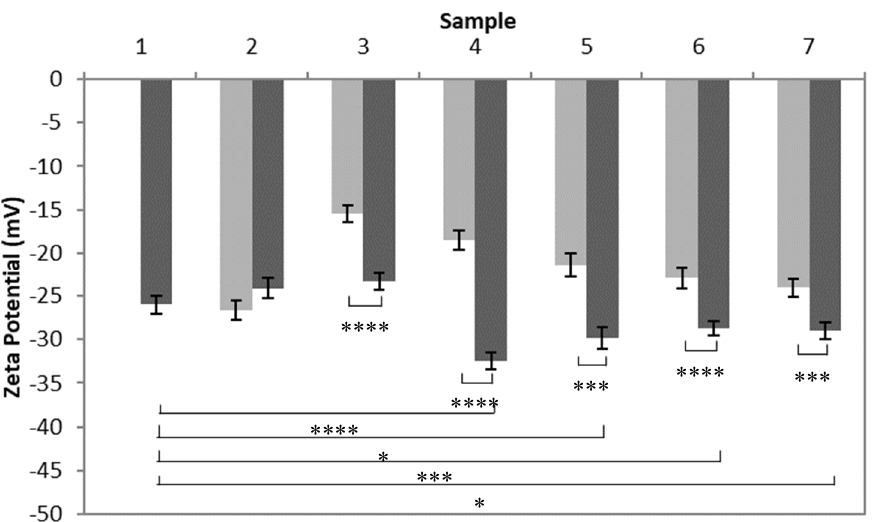
Figure 7. Zeta potential values of a mucin control solution (1), poly(HEMA, BAC) sample (2), and poly(HEMA, BAC, 3AAPBA) samples C2 (3), C3 (4), C4 (5), C5 (6), and C6 (7) from Table 3 with mucin ( ■ ) and without mucin ( ■ ). Error bars represent the standard error of 15 measurements. p value < 0.05 (*), < 0.005 (***), and < 0.0001 (****).